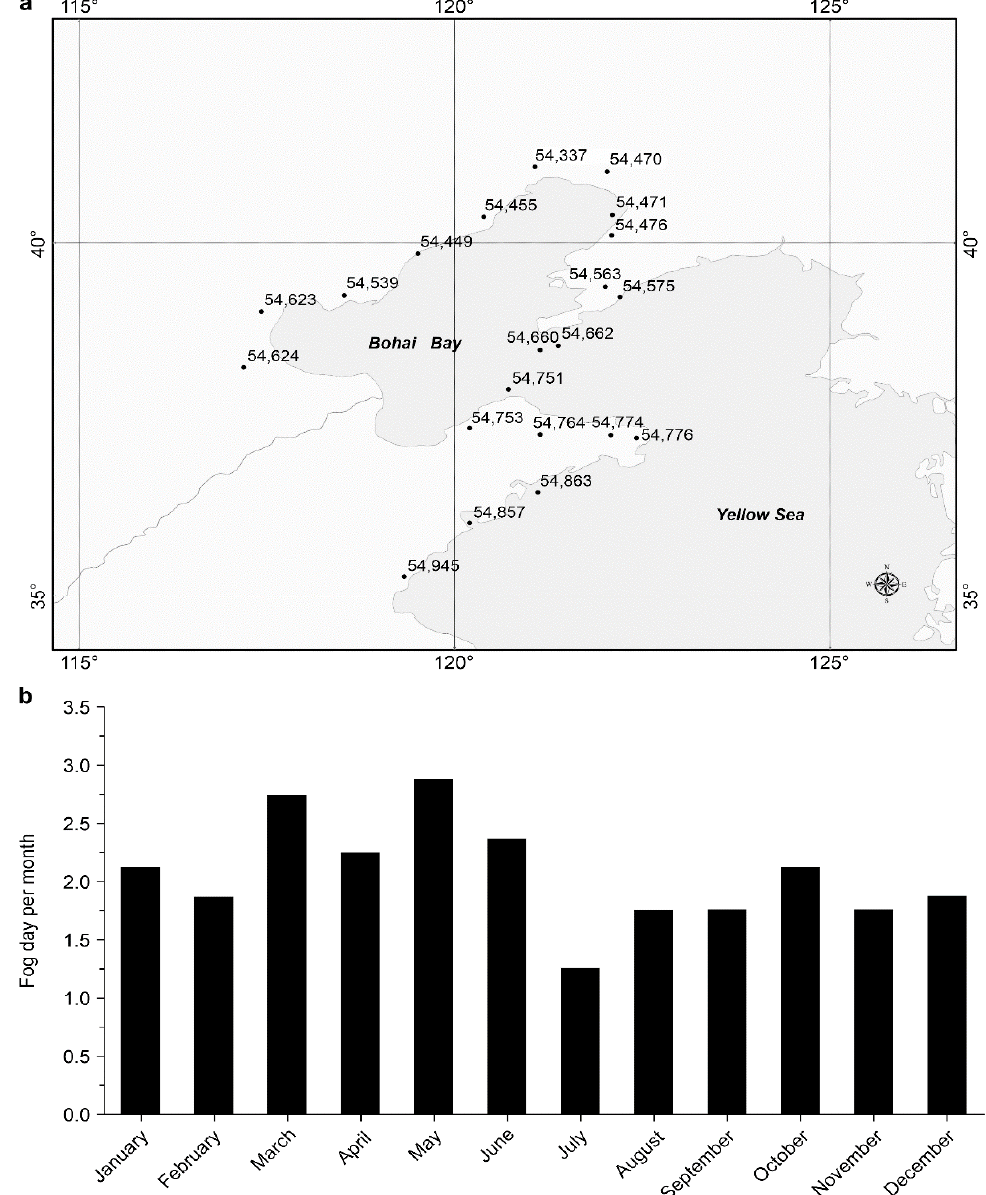
Figure 4. Monthly characteristics of sea fog events around the Yellow–Bohai Sea. ( a ) Distribution of coastal meteorology stations; ( b ) monthly statistical characteristics.